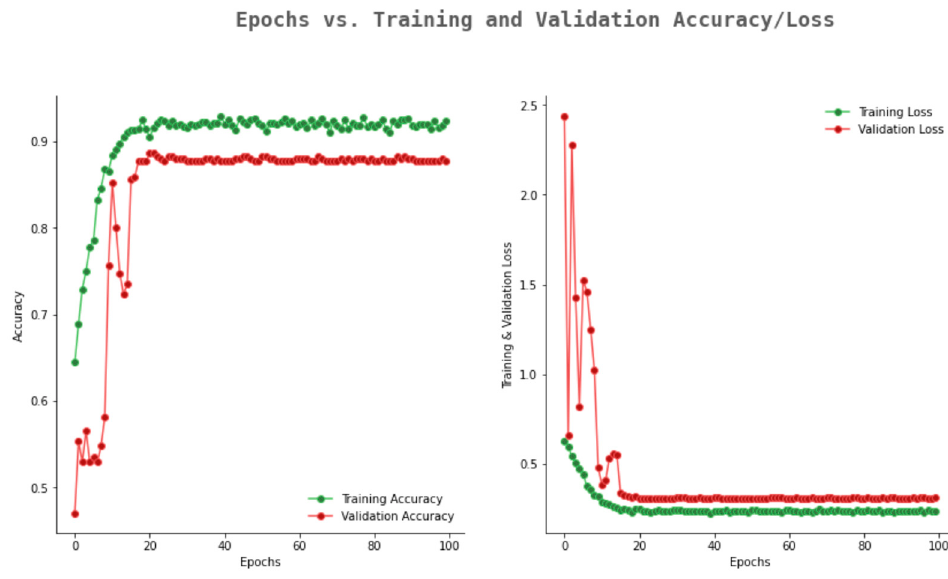
Figure 9. Accuracy and loss graph of Alexnet.